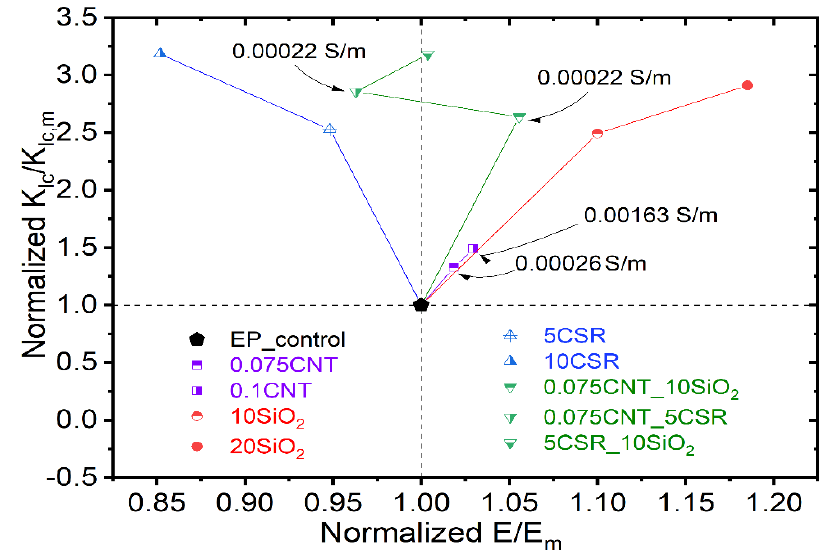
Figure 6. Normalized graph showing the relation between the normalized fracture toughness and normalized modulus of elasticity for different modified epoxy/amine systems in comparison to reference epoxy system. Electrically conductive systems are also mentioned in the figure.